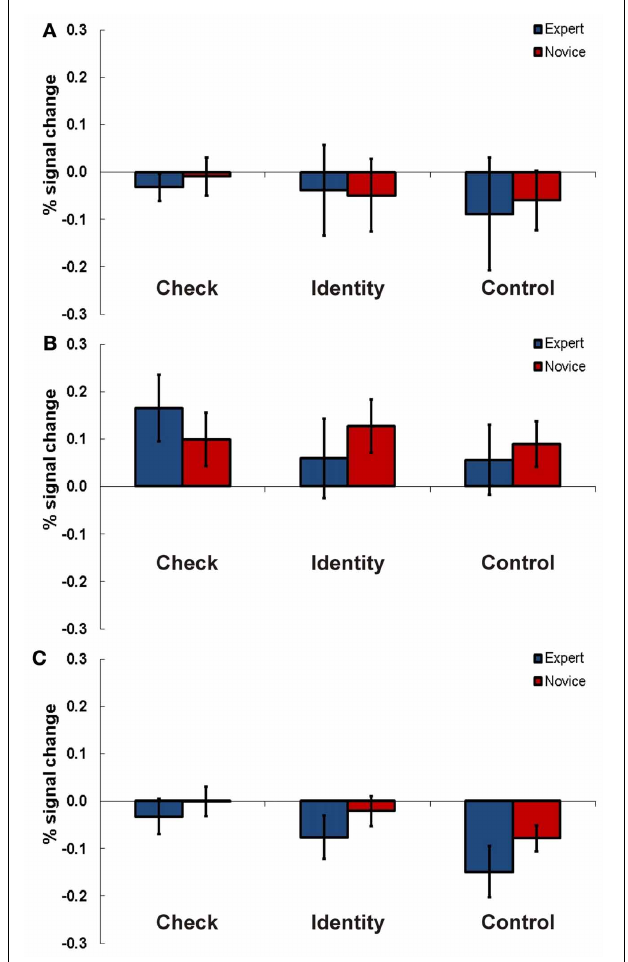
FIGURE 4 | Results Experiment 2. Percent signal change (PSC) for the three experimental conditions check (indicate if knight is in check), identity (recognition of a chess piece), and control (recognition of a geometrical shape) for experts and novices in TPJ ROI right (A) , left anterior (B) , and left posterior TPJ (C) . Error bars indicate standard error of the mean.